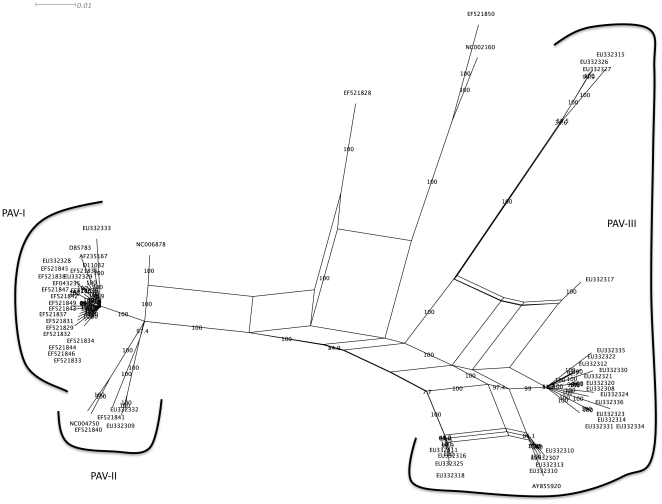
Split-decomposition phylogenetic network.Based on the 58 BYDV-PAV genomic sequences included in this study. Numbers over the branches represent bootstrap supports. The three PAV subspecies are indicated.